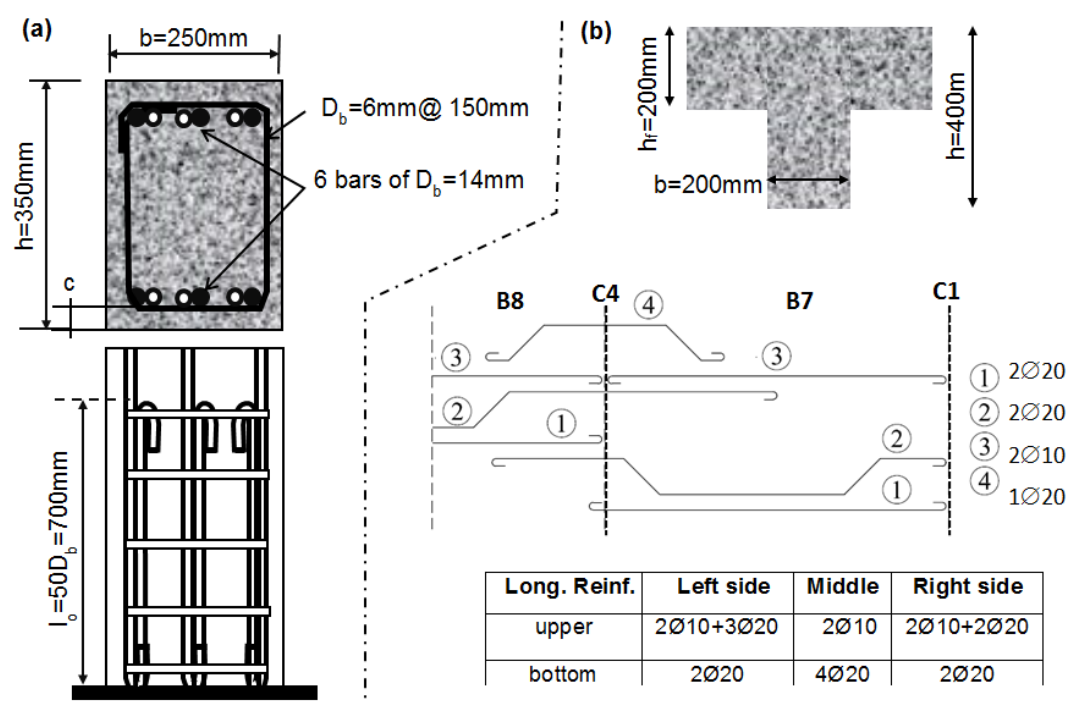
Figure 2. ( a ) Column cross section detailing and splice arrangement at column base and ( b ) beam geometry and longitudinal reinforcement detailing.